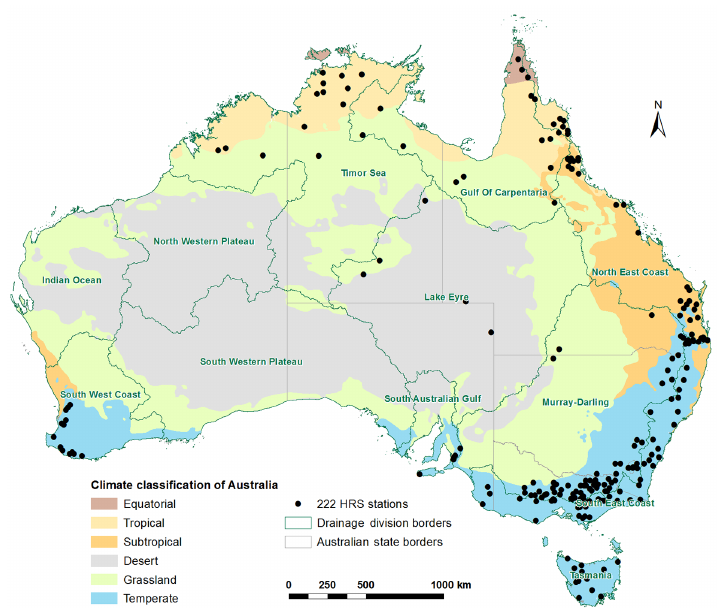
Figure 1. Location of the 222 high-quality streamflow reference stations, the climatic regions and Australia drainage divisions (Geofabric surface hydrology catchments, Geofabric V2.1; BOM,